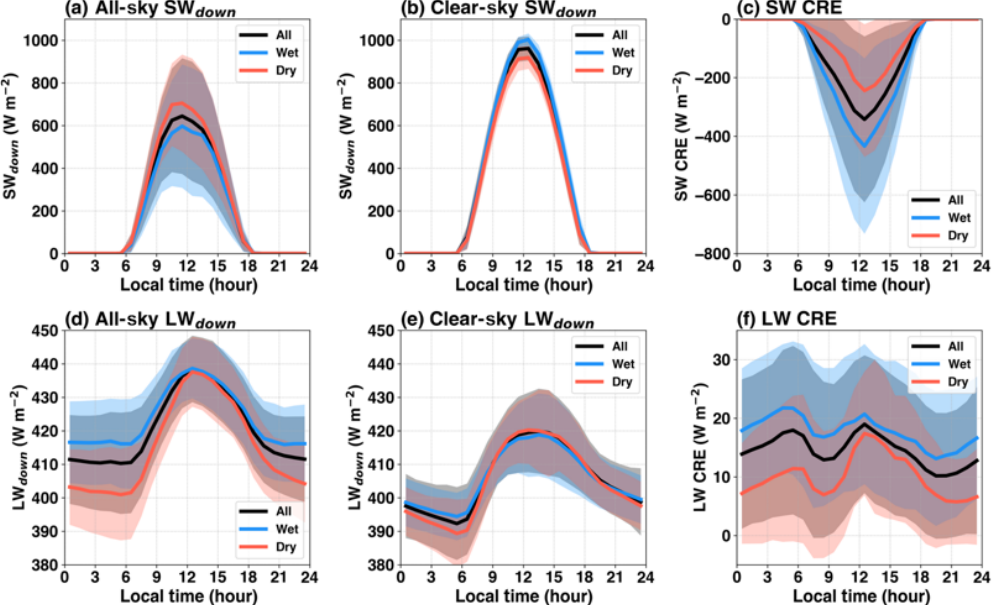
Figure 11. As in Table 3 except with the full diurnal cycle for the (a) mean downwelling SW radiative flux, (b) estimated clear-sky SW radiative flux, (c) aggregate SW cloud radiative effects, (d) downwelling LW radiative flux, (e) estimated clear-sky LW radiative flux and (f) aggregate LW cloud radiative effect. All units are in Wm − 2 . Shaded regions represent the observational standard deviation for these estimates during the hour.